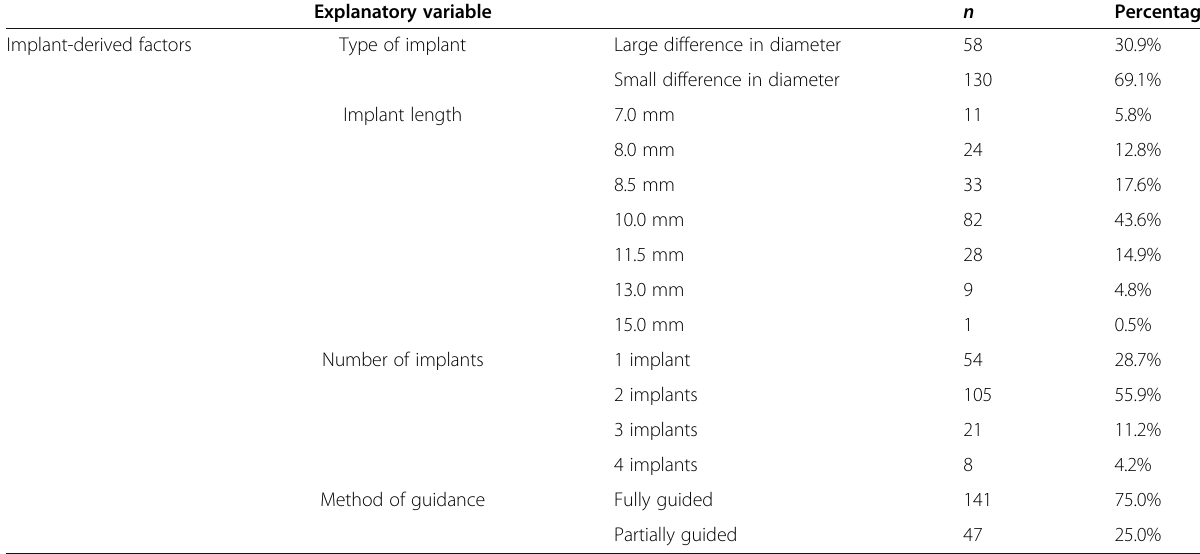
Table 4 Baseline data of explanatory variables Explanatory variable Implant-derived factors Type of